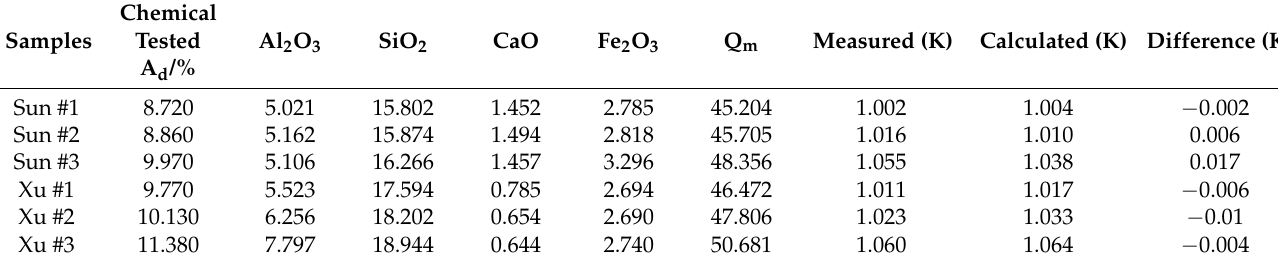
Table 5. Parameters for minerals from the Suntuan and Xutuan